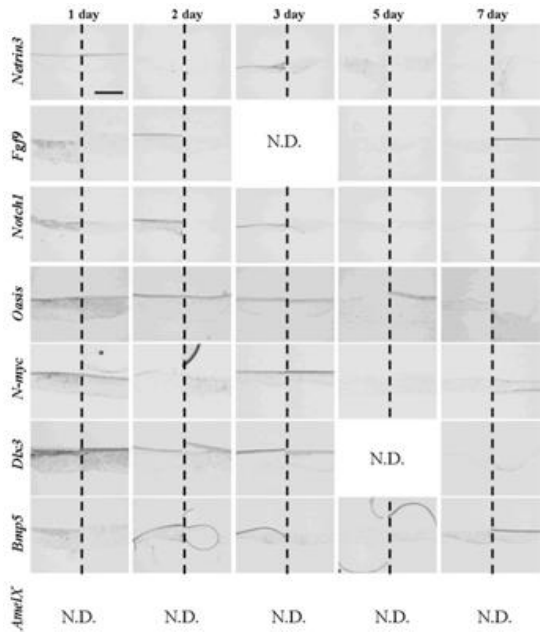
Figure 10. Gene expression pattern in germs reconstructed with emtg-2 cells and MT. Gene expressions were examined with in-situ hybridization with anti-sense probe in left and sense probe in right of each panel. Germs were cultured on inserts for one to seven